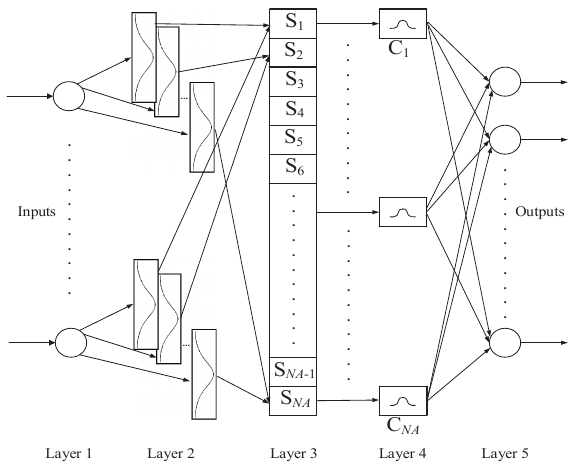
Figure 1. The structure of the Fuzzy Cerebellar Model Articulation Controller (FCMAC) model.